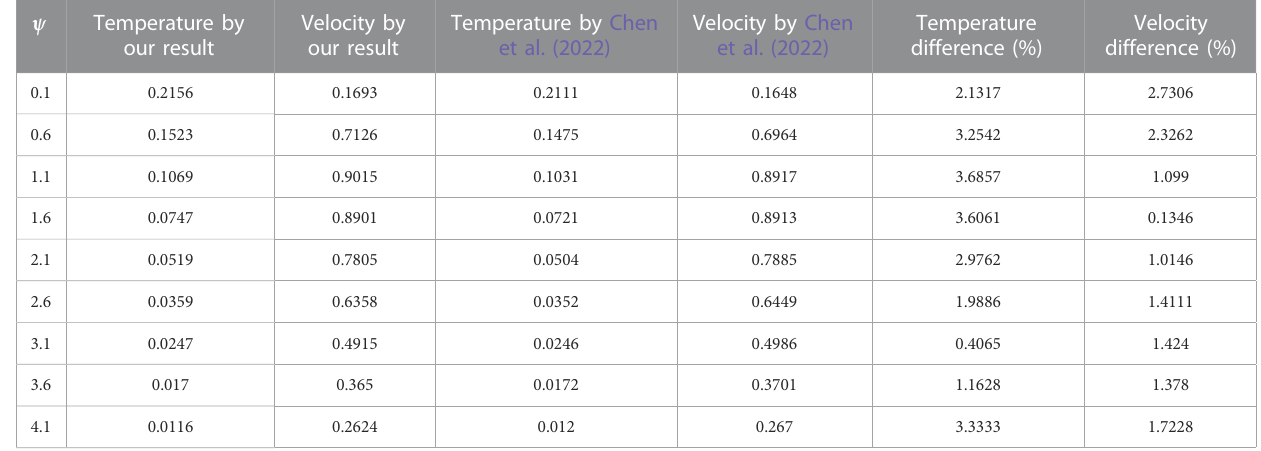
TABLE 4 Numerical results of comparisons of the velocity fi eld. ψ Temperature by Velocity by Temperature by Chen our result our result et al.